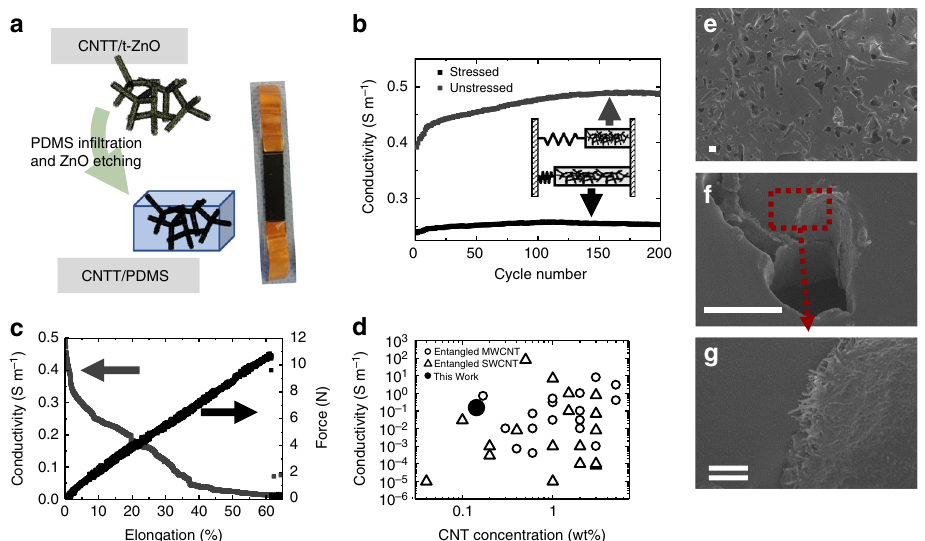
Fig. 4 Overview of the CNTT/PDMS porous stretchable conductors and their mechanical and electrical characteristics. a Left: schematic representation showing the PDMS in fi ltration into the CNTT/t-ZnO composite and subsequent ZnO etching with HCl. Right: stretchable porous conductor used for conductivity measurements; b Conductivity against cycle number for the unstressed (0% elongation) and the stressed (13.3% elongation) state, showing an increase in conductivity for both states during cycling (CNT concentration was 11.3×10 – 3 g cm − 3 ); c Mechanical and electrical properties under tensile stress of a porous stretchable conductor having a CNT concentration of 11.3×10 – 3 g cm − 3 . With increasing elongation, the conductivity decreases. d Comparative log – log plot of maximum conductivity as a function of CNT weight fraction (adopted from ref. 47 ); e – g SEM images of the CNTT/PDMS composites showing the interconnected channels with CNT decorated walls after template removal by HCl (Scale bars: single line: 10 µ m, double line: 1 µ